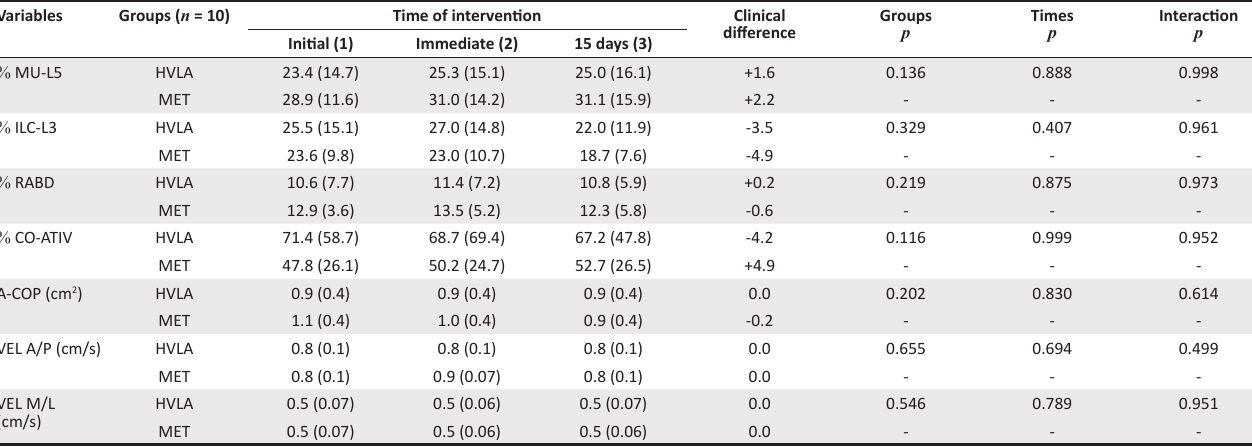
TABLE 3: Changes in trunk neuromuscular activation and postural control during balance standing task with trunk external load.